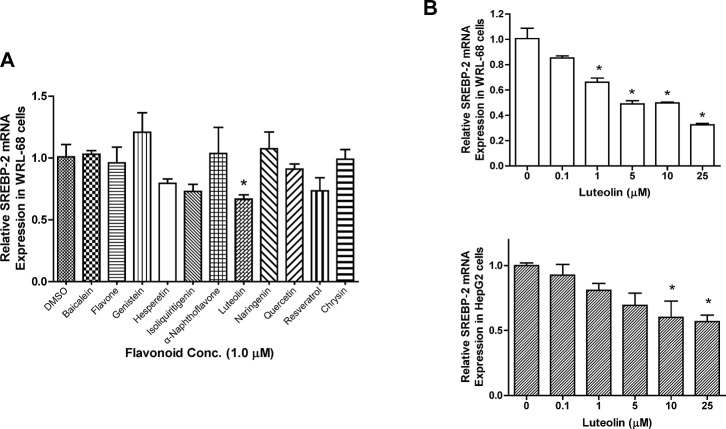
Differential effects of flavonoids on SREBF2 mRNA expression.The hepatic cells WRL-68 were seeded onto 6-well culture plates and treated with various flavonoids at 1 μM. After 24 h of treatment, total mRNA samples were extracted from the cells. SREBF2 mRNA expression was determined using real-time RT-PCR (Fig 1A). Dose-response experiments were performed with luteolin at 0, 0.1, 1, 5, 10 and 25 μM in WRL-68 (upper panel) and HepG2 cells (lower panel) as a follow-up to the screening (Fig 1B). The values are presented as the means ±SEM, n = 3 samples per treatment. Means labeled with (*) are significantly different.